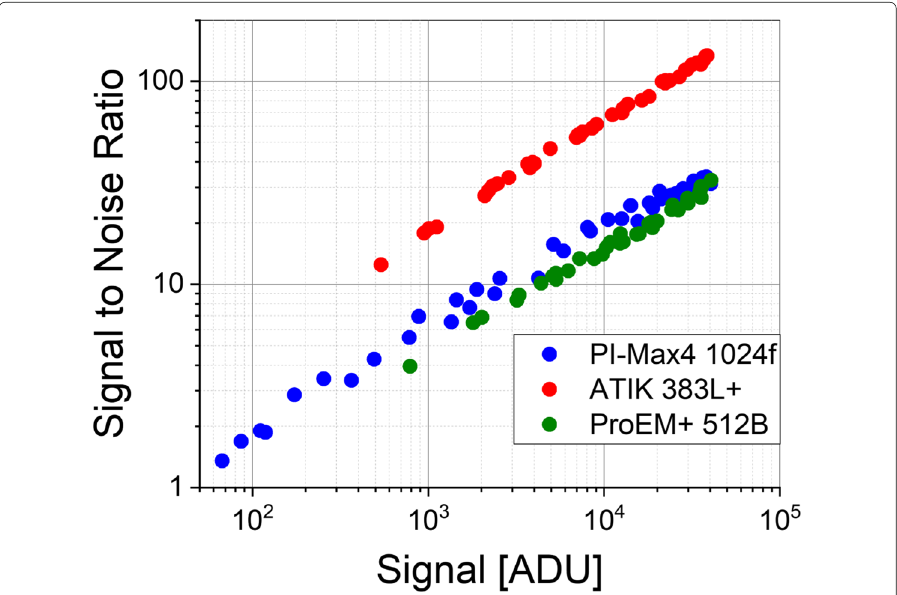
Fig. 9 The signal to noise ratio (SNR) of the three camera systems is shown versus the absolute signal. The different signal strengths were obtained by varying the exposure time recording the light source with fixed